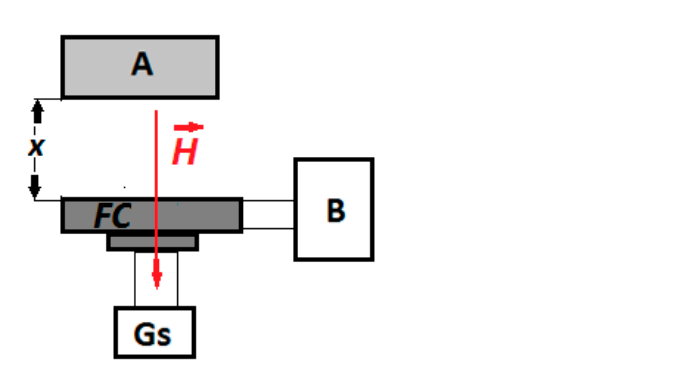
Figure 1. Experimental setup (overall configuration): A—neodymium magnet; B—impedance meter (type ET-20); FC—working flat capacitor; (cid:1834)(cid:4652)(cid:4652)(cid:1318) —magnetic field strength vector; Gs—Gaussmeter, type DX-102; h—Hall probe; x —adjustable distance.